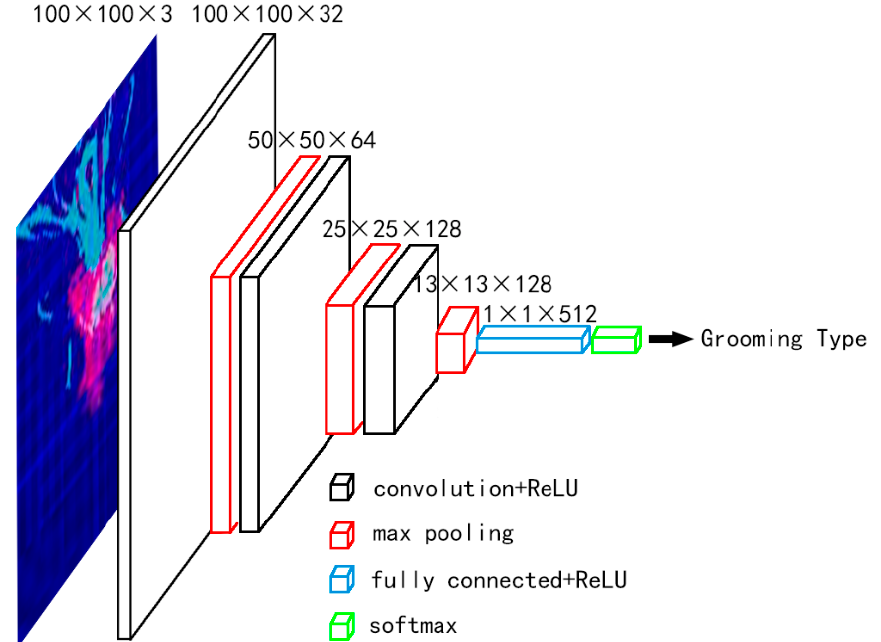
Figure 5. The CNN structure adopted in this paper.